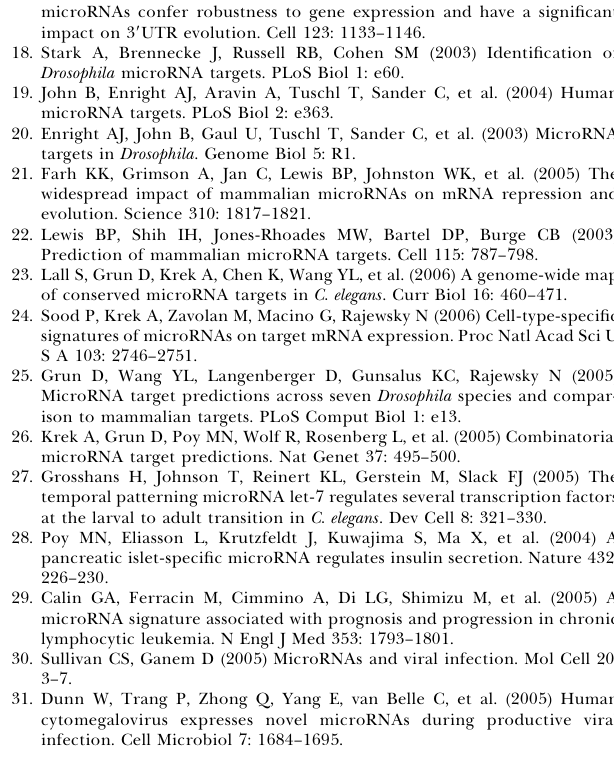
Figure S1. Locations of the Top 100 Predicted 9-mers in the Upstream Regions of Protein-Coding Genes Found at doi:10.1371/journal.pcbi.0030067.sg001 (1.3 MB PDF). Figure S2. Locations of the Top 100 Predicted 8-mers in the Upstream Regions of Protein-Coding Genes Found at doi:10.1371/journal.pcbi.0030067.sg002 (1.3 MB PDF). Figure S3. Locations of the Top 100 Predicted 7-mers in the Upstream Regions of Protein-Coding Genes Found at doi:10.1371/journal.pcbi.0030067.sg003 (1.4 MB PDF). Figure S4. Locations of the Top 100 Predicted 6-mers in the Upstream Regions of Protein-Coding Genes Found at doi:10.1371/journal.pcbi.0030067.sg004 (1.5 MB PDF). Figure S5. Locations of All (14) Predicted 5-mers in the Upstream Regions of Protein-Coding Genes Found at doi:10.1371/journal.pcbi.0030067.sg005 (219 KB PDF). Figure S6. Locations of 100 Randomly Selected 9-mers in the Upstream Regions of Protein-Coding Genes Figure S7. Locations of 100 Randomly Selected 8-mers in the Upstream Regions of Protein-Coding Genes Found at doi:10.1371/journal.pcbi.0030067.sg007 (1.5 MB PDF). Figure S8. Locations of 100 Randomly Selected 7-mers in the Upstream Regions of Protein-Coding Genes Figure S9. Locations of 100 Randomly Selected 6-mers in the Upstream Regions of Protein-Coding Genes Found at doi:10.1371/journal.pcbi.0030067.sg009 (1.5 MB PDF). Figure S10. Locations of 14 Randomly Selected 5-mers in the Upstream Regions of Protein-Coding Genes Found at doi:10.1371/journal.pcbi.0030067.sg010 (233 KB PDF).